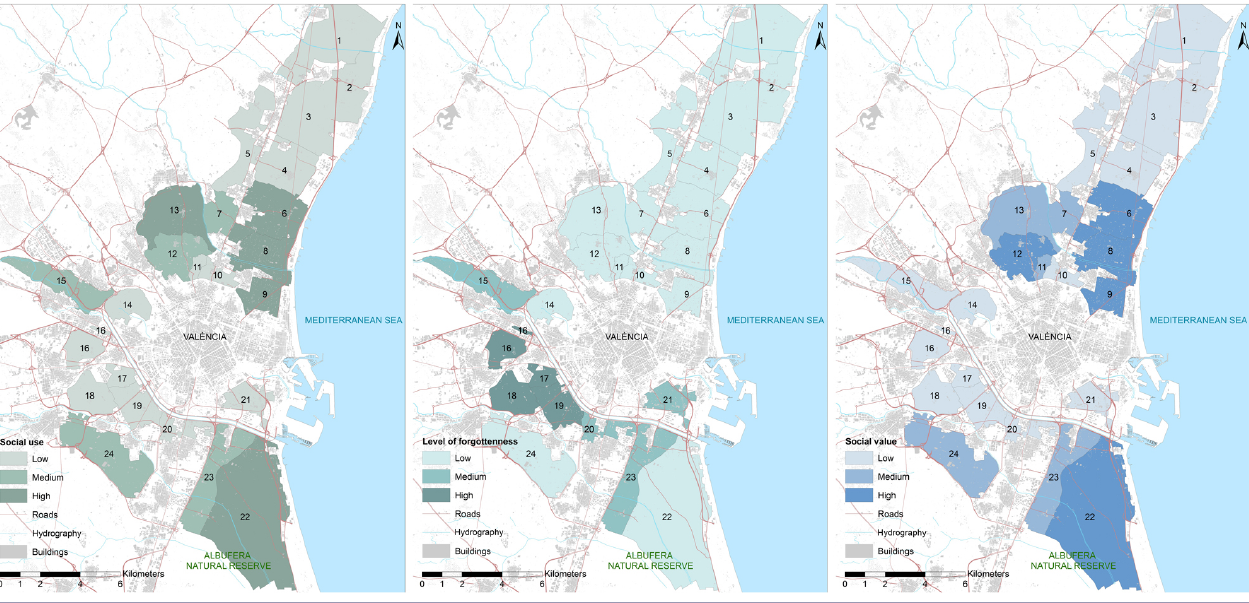
Fig. 3. Maps showing the level of social use, social memory, and social value of the landscape character areas in Huerta de